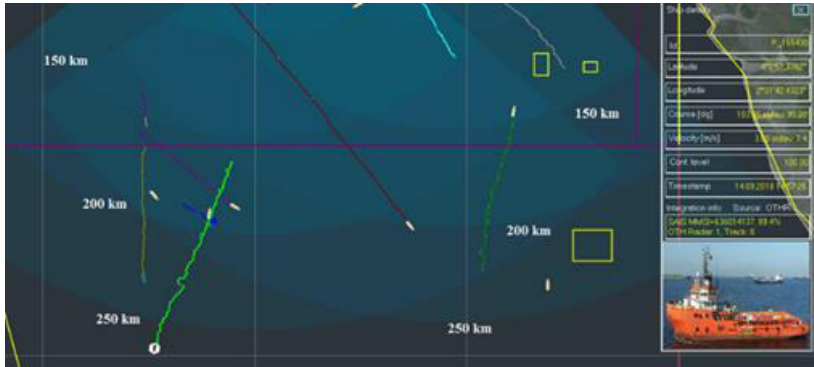
Figure 8. Surveillance during favorable weather conditions.